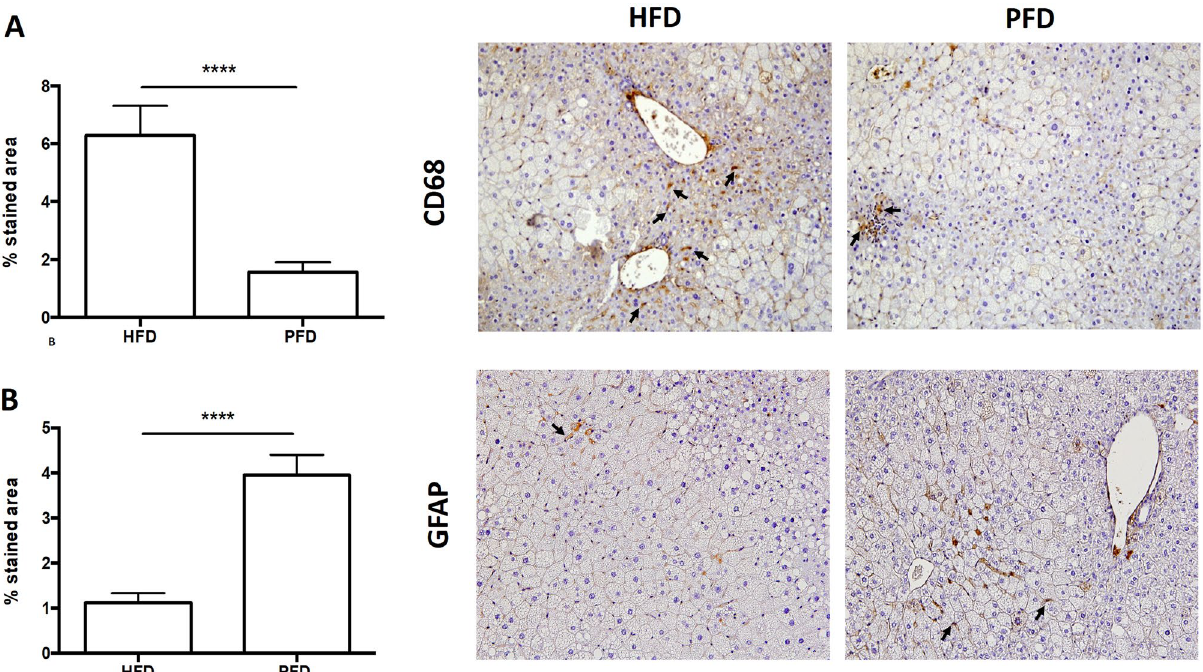
Figure 3. Immunoreactivity against CD68 and GFAP. ( A ) In animals fed with high fat-high carbohydrate diet an increase in CD68 immunoreactivity was observed. Animals treated with PFD showed a significant reduction in CD68 positive area (****p < 0.0001). ( B ) Quantification of GFAP positive area in liver tissue showed an increased in PFD animals (****p < 0.0001). Photographs at ×20 magnification. HFD: high fat and high carbohydrate diet and PFD: high fat and high carbohydrate diet + prolonged-release pirfenidone. Data are expressed as the media of the group ± SEM.